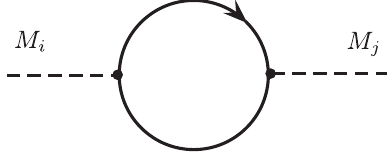
FIG. 1. Correlator of the nematic order